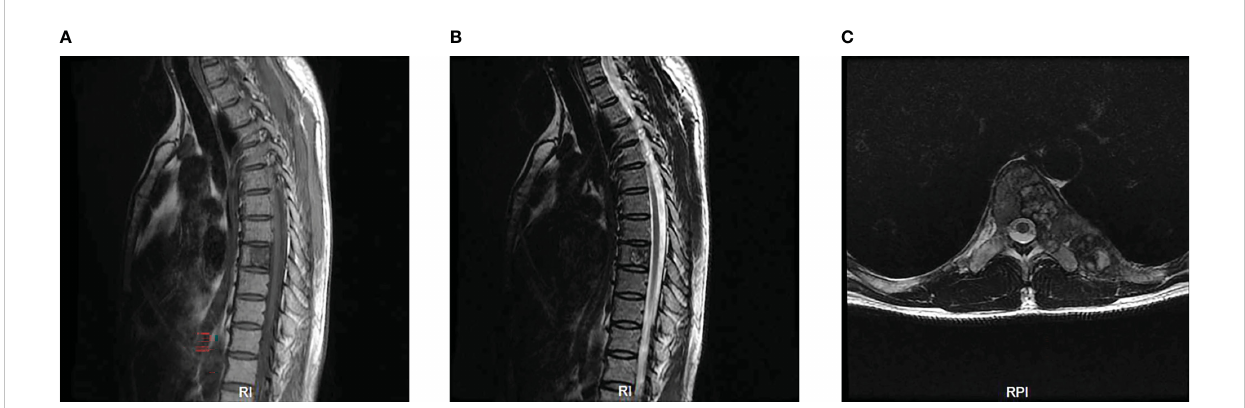
FIGURE 1 Preoperative MRI scan of the patient ’ s thoracic spine (A – C) . Sagittal scan revealed the density of obvious bone destruction in the T8 on T1 and T2- weighted images (A, B) . Transverse MRI scan showed a 6.5cm x 2.0cm sized and well-de fi ned lesion occupying the T8 vertebral body, pedicle and lamina (C)